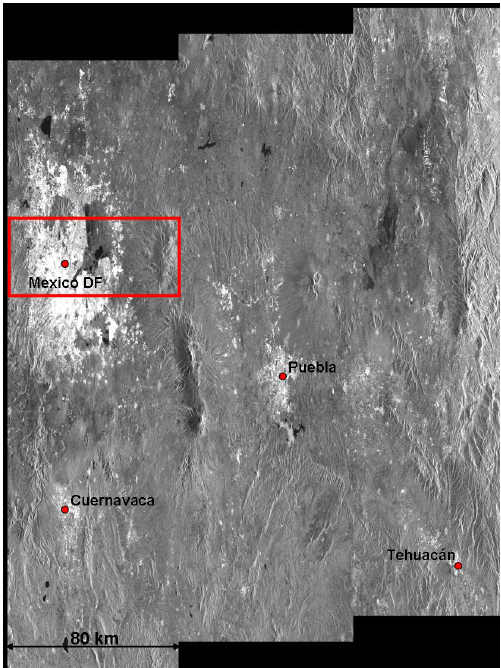
Figure 1. SAR amplitude of the Mexico dataset. Scene acquired by the Sentinel-1 satellite covering approximately 250 by 180km. The red square indicates the area processed using the PSI